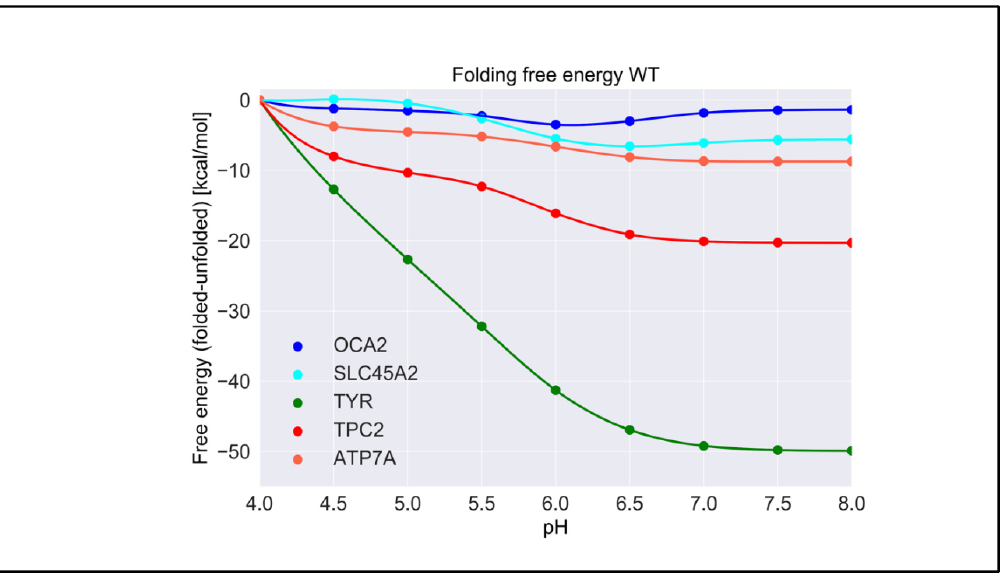
Figure 3. The pH dependence of the folding free energy of wild-type proteins from minimized structures within pH range 4–8.